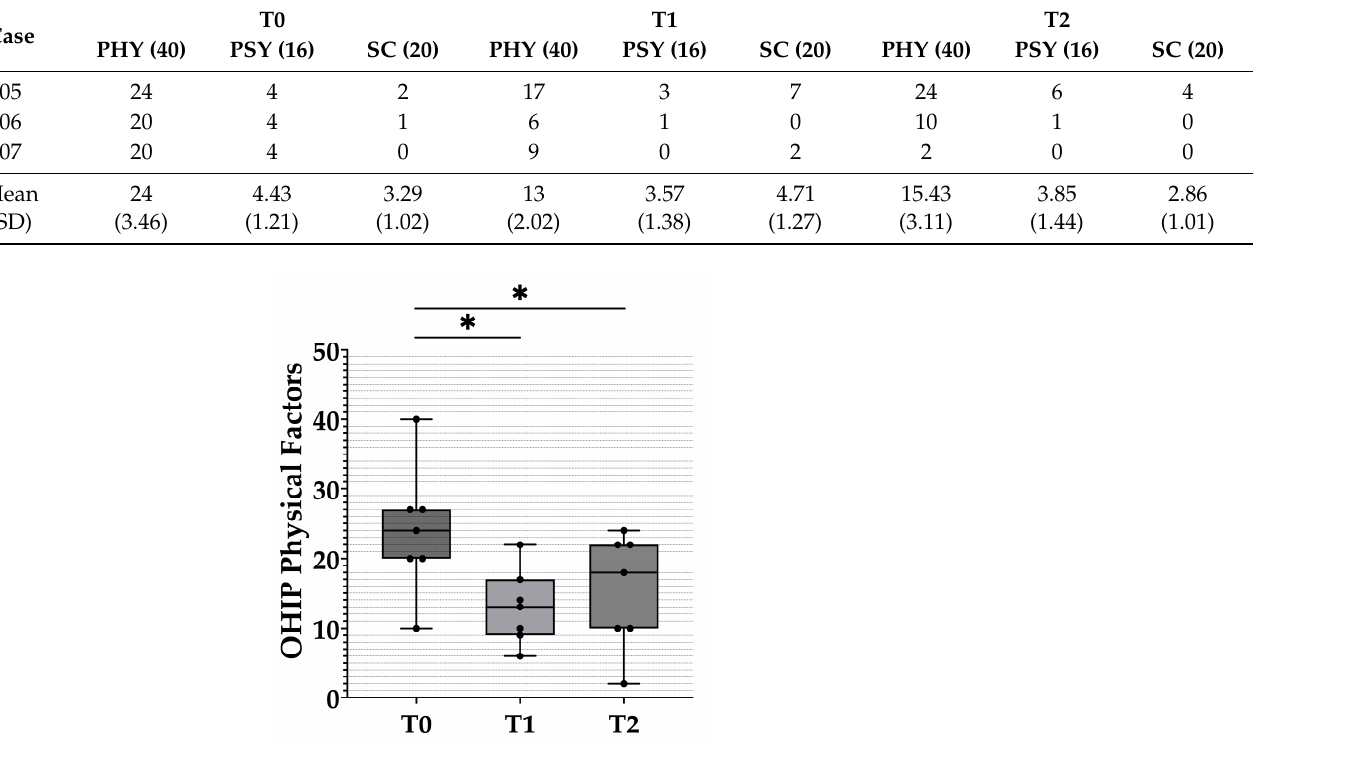
Figure 4. Box plots of the physical impact scores from the OHIP-EDENT-J questionnaire. The black dots represent the distribution of raw data. T0: before the clinical remount. T1: immediately after the clinical remount. T2: 1 week after the clinical remount. Statistical analysis was performed with the Wilcoxon sign-rank test. Predetermined level of significance: p < 0.05 (*).